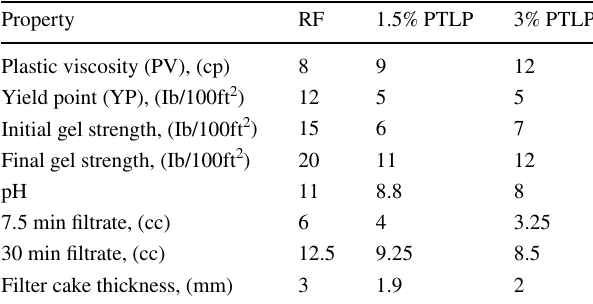
Table 1 The results of adding various concentrations of PTLP to the reference fluid (fresh conditions)